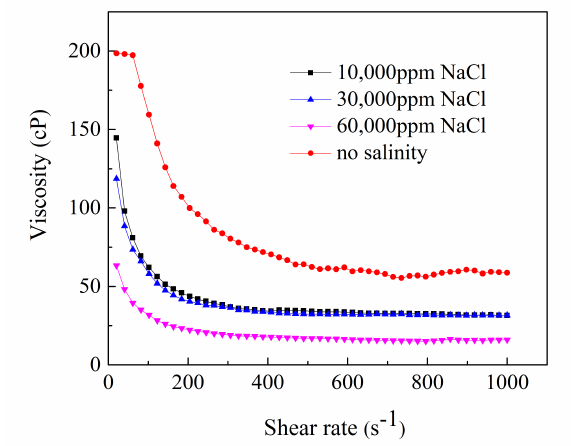
Fig. 7. TGA curves of HPAM and HPAM-SiO 2 NPs.